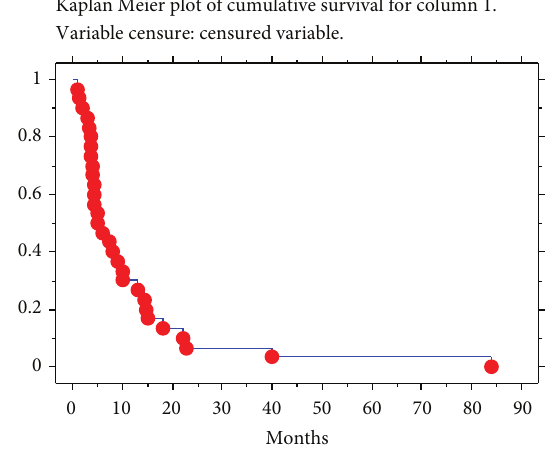
Figure 1: Overall survival